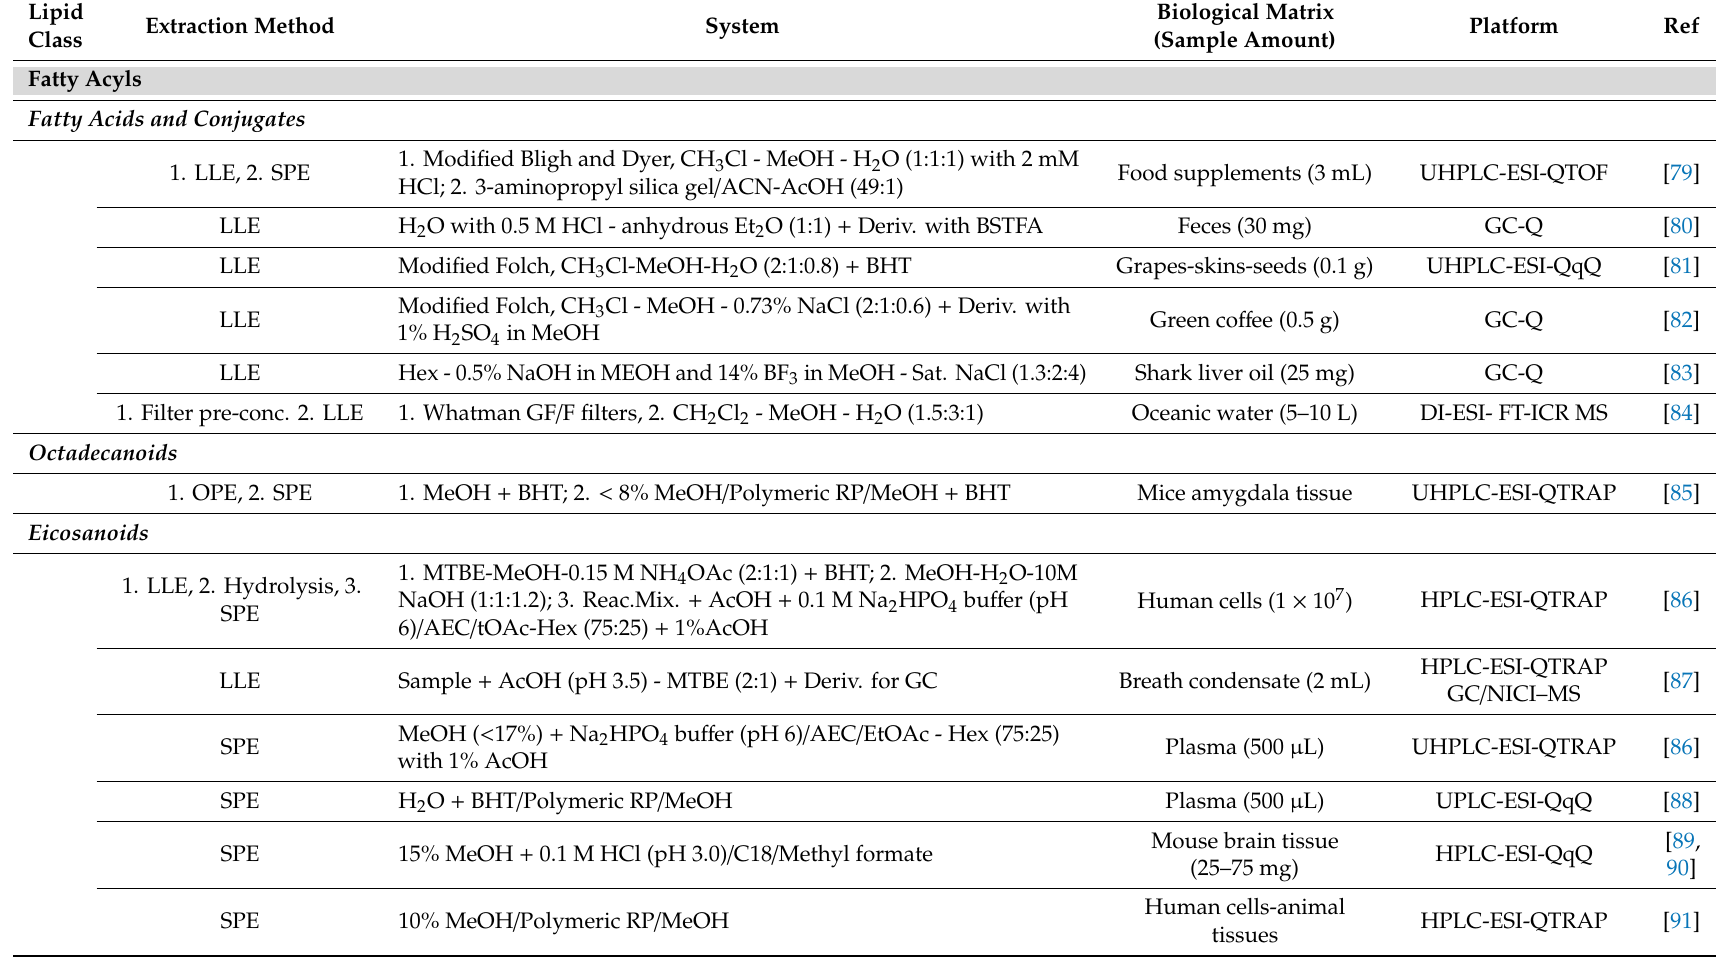
Table 3. Reports of targeted extraction of lipids by